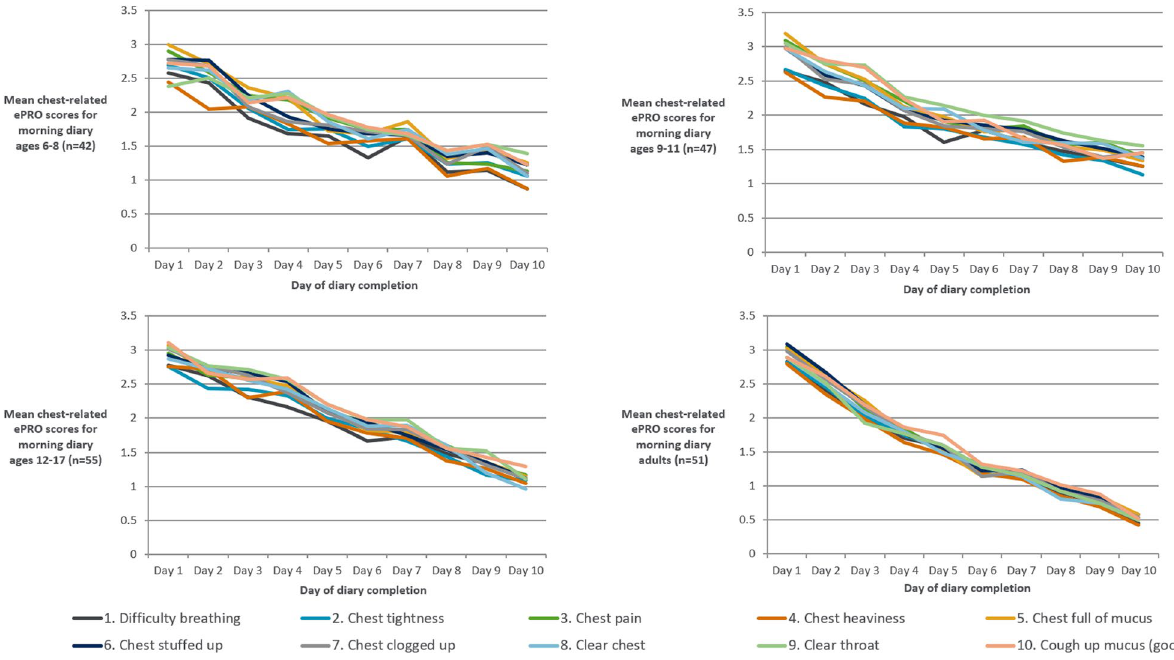
Fig. 3 Mean chest-related ePRO scores for the morning diary across all age groups from Day 1 to Day 10